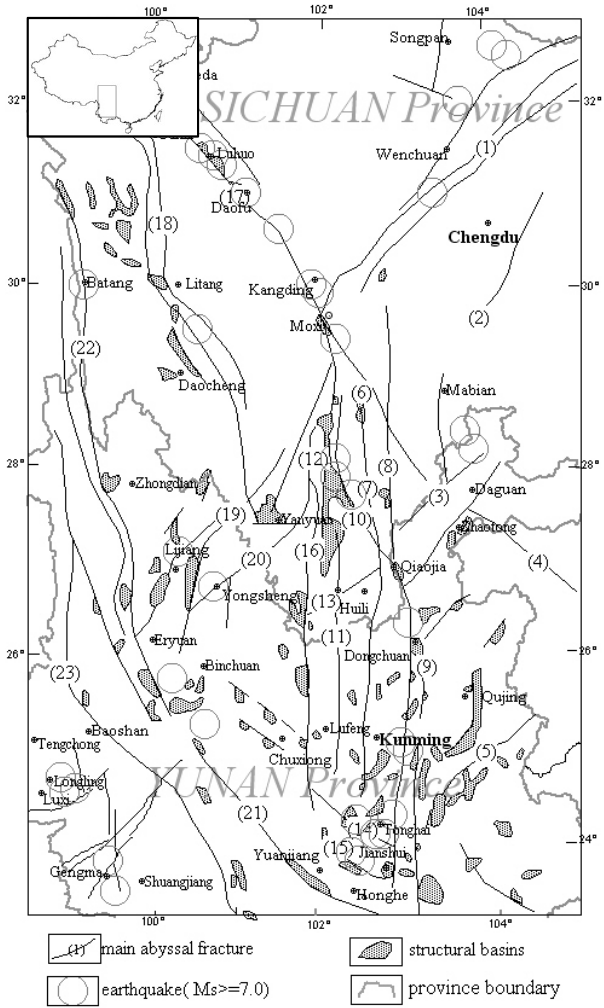
Fig. 1. Distribution of the main faults and structural basins in south- Fig 1. Distribution of the main faults and structural basins in southwest China (revised from Southwest China west China (revised from Southwest China Intensity Zoning Team Intensity Zoning Team of State Seismological Bureau) of State Seismological Bureau), (1) Longmenshan fault; (2) Emei- (1) Longmenshan fault; (2) Emei-Jinyang fault; (3) Lianfeng-Qiaojia fault; (4) Yiliang-Shuicheng fault; (5) Jinyang fault; (3) Lianfeng-Qiaojia fault; (4) Yiliang-Shuicheng fault; (5) Mile-Shizong fault; (6) Puxionghe fault; (7) Xiluohe Mile-Shizong fault; (6) Puxionghe fault; (7) Xiluohe fault; (8) Luoxi fault; (9) Xiaojiang fault; (10) Zemuhe fault; fault; (8) Luoxi fault; (9) Xiaojiang fault; (10) Zemuhe fault; (11) Anninghe fault; (12) Nanhe fault; (13) Ninghui fault; (14) Qujiang fault; (15) Shiping-Jianshui fault; (16) (11) Anninghe fault; (12) Nanhe fault; (13) Ninghui fault; (14) Qu- Mopanshan-Lvzhijiang fault; (17) Xianshuihe fault; (18) Litang fault; (19) Xiaojinhe fault; (20) jiang fault; (15) Shiping-Jianshui fault; (16) Mopanshan-Lvzhijiang Jinhe-Yongsheng-Binchan fault; (21) Yuanjiang fault; (22) Jinshajiang fault; (23) Lancangjiang fault fault; (17) Xianshuihe fault; (18) Litang fault; (19) Xiaojinhe fault; (20) Jinhe-Yongsheng-Binchan fault; (21) Yuanjiang fault; (22) Jin- shajiang fault; (23) Lancangjiang